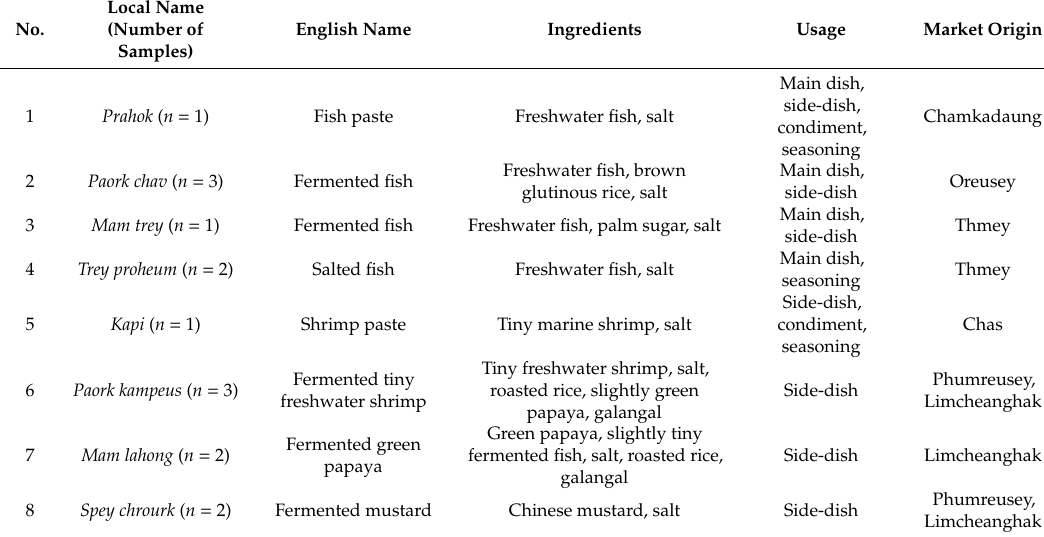
Table 1. Selected Cambodian fermented food